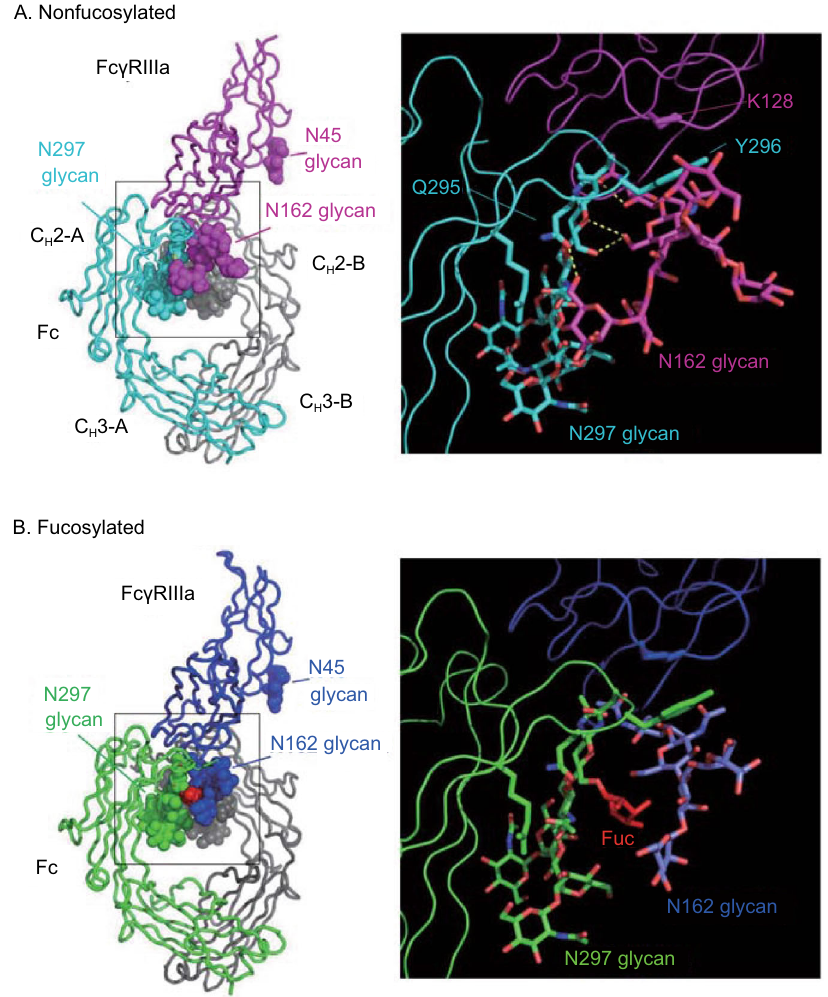
Figure 3. Crystal structures of the complexes between Fc γ RIIIa and nonfucosylated Fc (A) or fucosylated Fc (B). (A) The nonfucosylated Fc chains A and B are shown in cyan and gray, respectively, and the Fc γ RIIIa in pink. (Right) The close-up view of the interaction interface between nonfucosylated Fc and glycosylated Fc γ RIIIa. (B) The fucosylated Fc chains are shown in green and gray, and the Fc γ RIIIa in blue. (Right) The close-up view of the interaction interface between fucosylated Fc and glycosylated Fc γ RIIIa. The oligosaccharides are shown in sphere (Left) and stick (Right) representation. Hydrogen bonds are presented as dashed lines. The molecular models were produced with PyMOL (The PyMOL Molecular Graphics System, Version 1.8.5.0, Schrodinger,